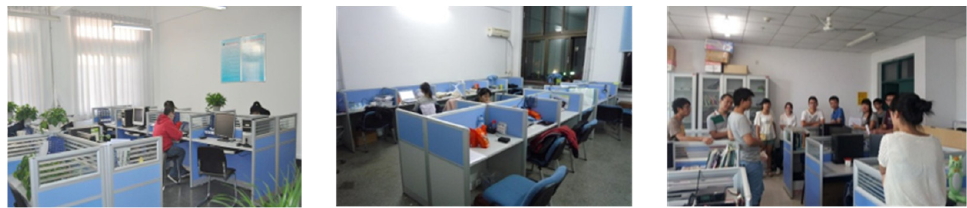
Figure 1. Indoor views of typical research student offices in some universities of China.